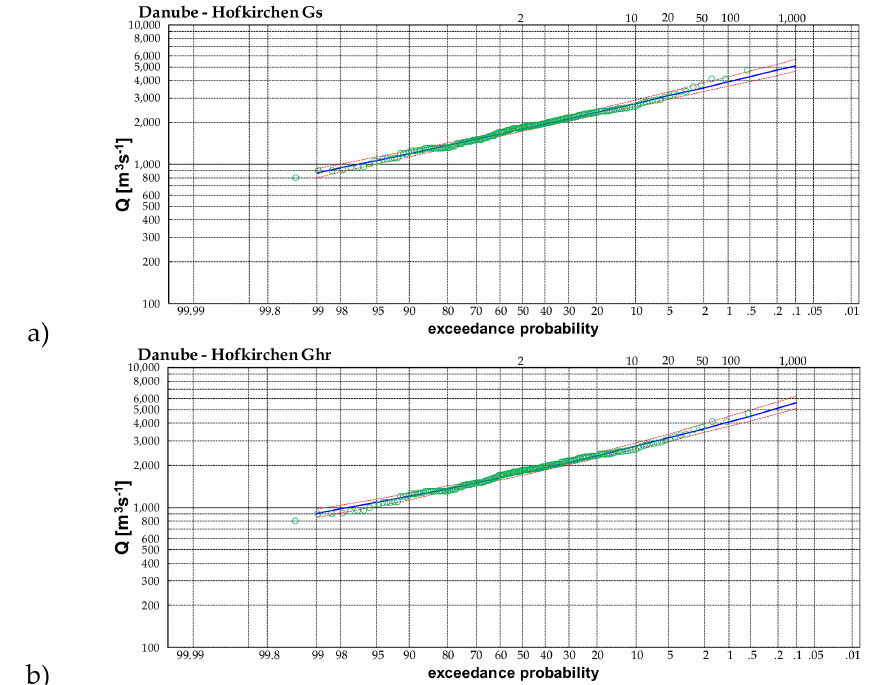
Figure 9. Examples of the theoretical LPIII exceedance probability curves of the Danube maximum annual discharges with ( a ) station skew parameter Gs and ( b ) regionalized skew parameter Ghr for the Danube at